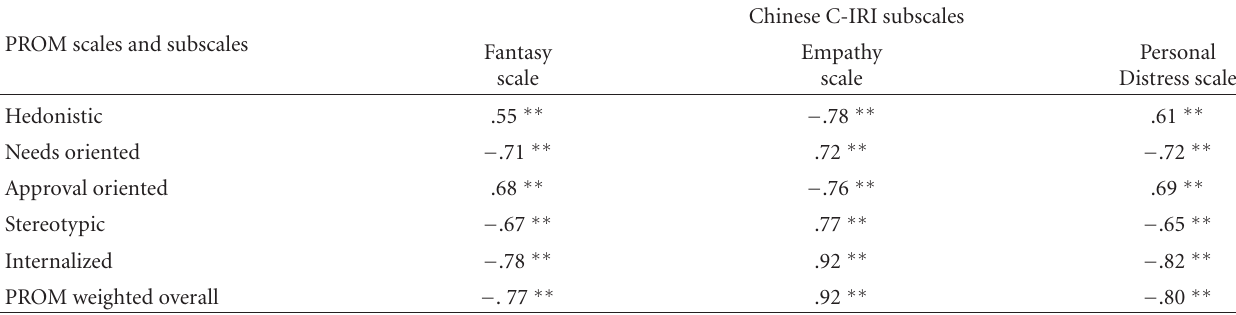
Table 2: Correlation between the Chinese PROM and the C-IRI (measure of empathy and related constructs) ( N = 50). PROM scales and subscales